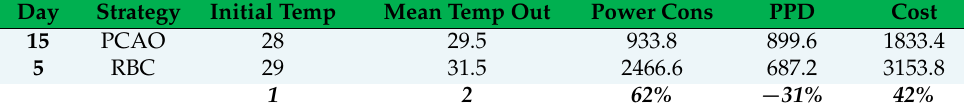
Table 9. Comparison between the PCAO (15th) and RBC (5th) summer